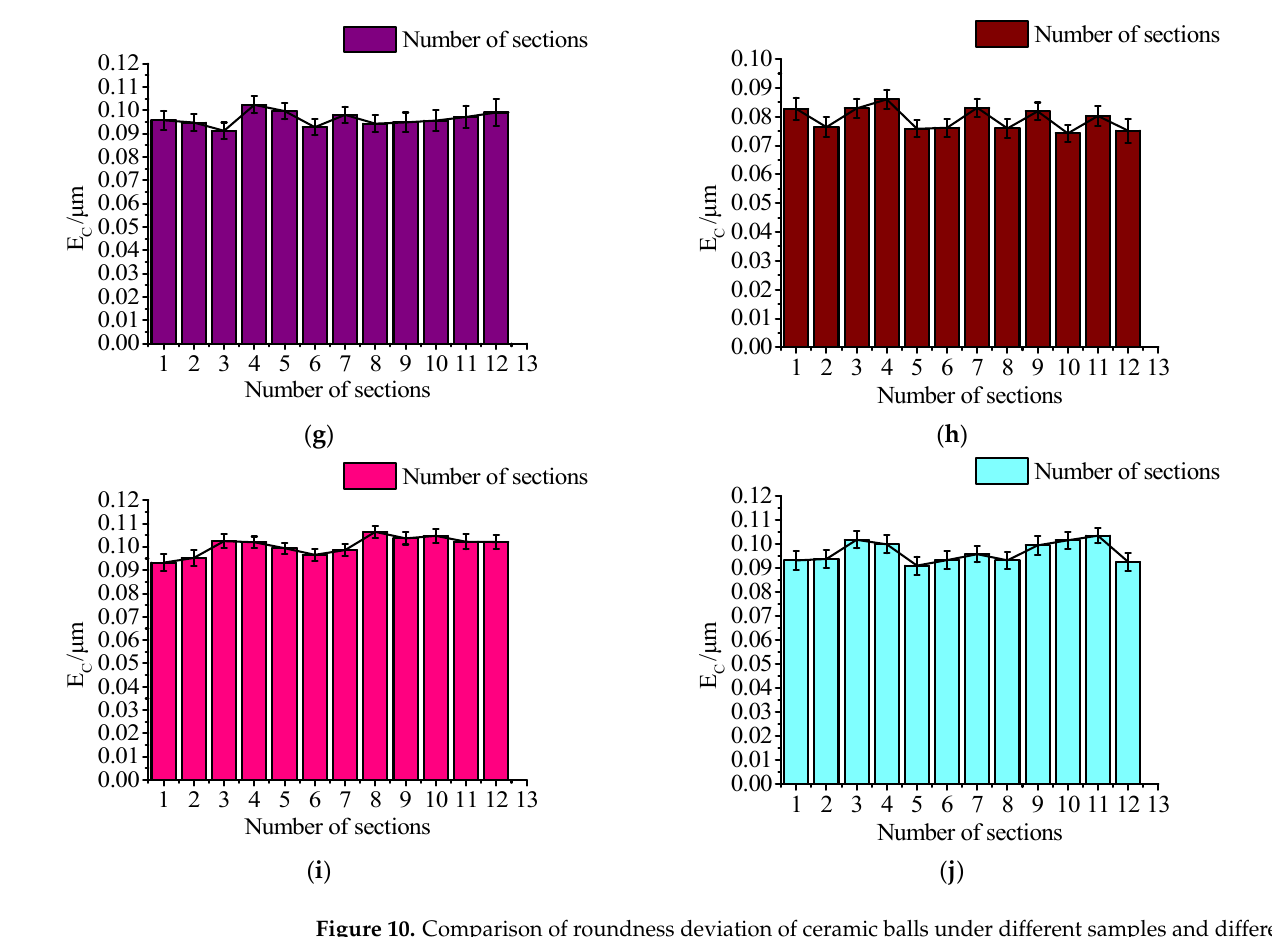
Figure 10. Comparison of roundness deviation of ceramic balls under different samples and different sections of the same sample. ( a ) The E C values under different cross sections of Sample 1; ( b ) The E C values under different cross sections of Sample; ( c ) The E C values under different cross sections of Sample 3; ( d ) The E C values under different cross sections of Sample 4; ( e ) The E C values under different cross sections of Sample 5; ( f ) The E C values under different cross sections of Sample 6; ( g ) The E C values under different cross sections of Sample 7; ( h ) The E C values under different cross sections of Sample 8; ( i ) The E C values under different cross sections of Sample 9; ( j ) The E C values under different cross sections of Sample 10.